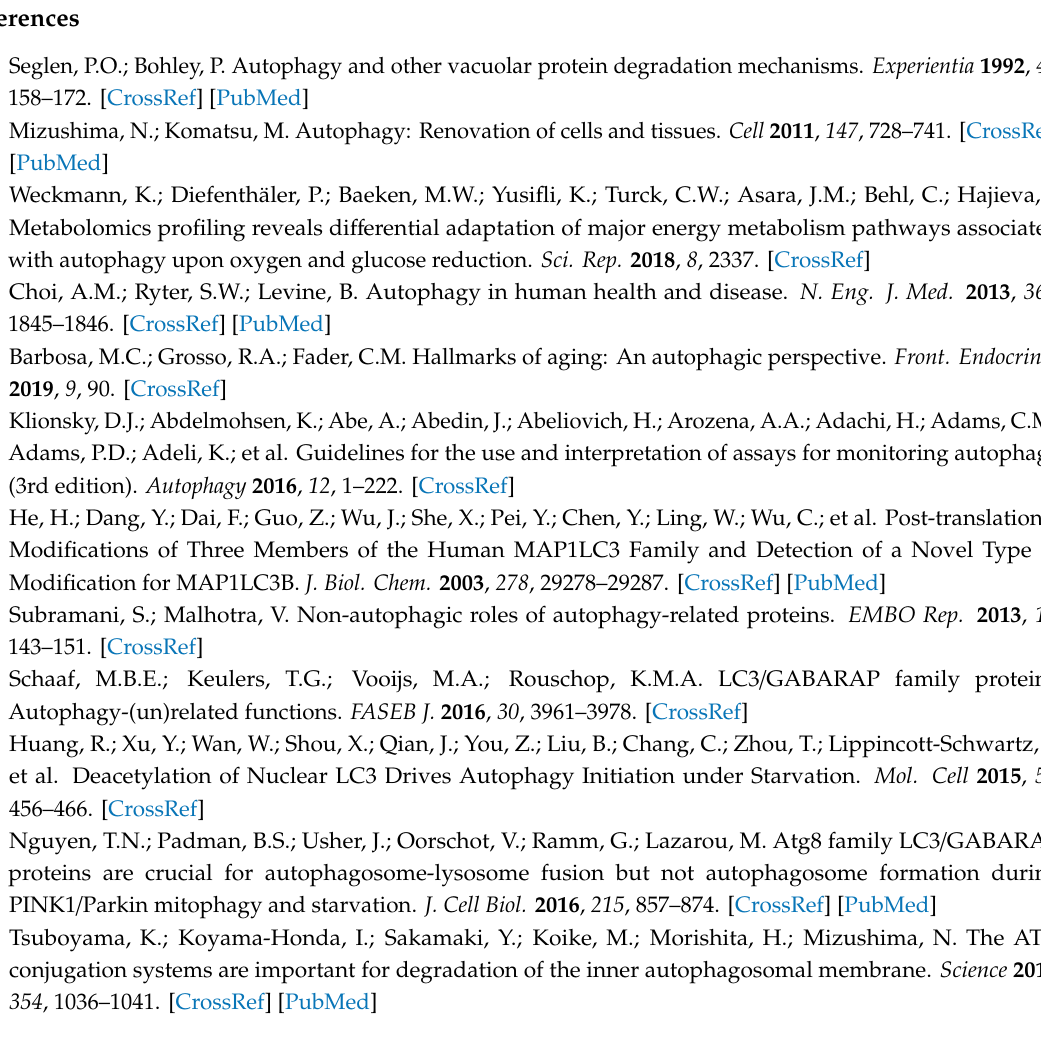
Figure S1: Cellular localization of LC3A, LC3B, LC3C, and p62 proteins upon Ex527 or TSA treatment, Figure S2: Cellular distribution of p62 upon Ex527 or TSA treatment with or without treatment with BafA1, Figure S3: Acetylation status of LC3A, LC3B and LC3C upon Ex527 or TSA treatment, Figure S4: Analysis of the cellular localization of LC3A, LC3B and LC3C in response to siRNA-mediated Lamp2 knock-down under di ff erent